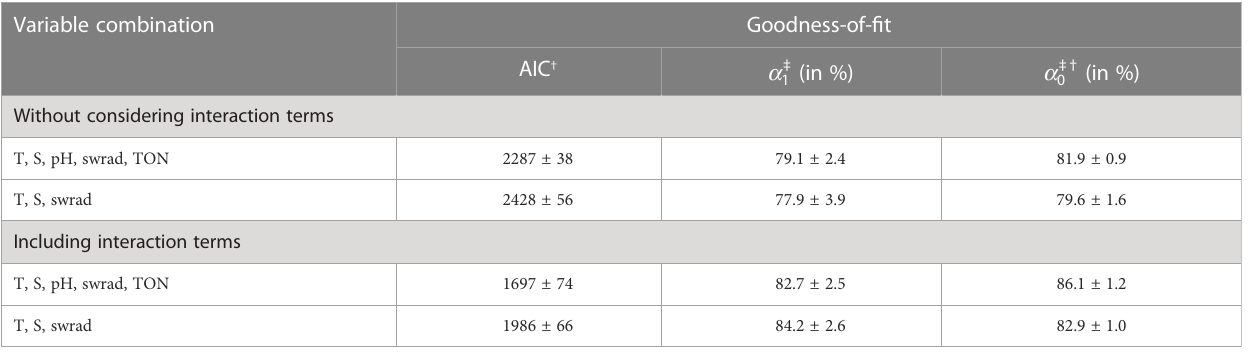
TABLE 4 Goodness-of- fi t corresponding to the generalized additive model with and without consideration of interaction terms. Variable combination